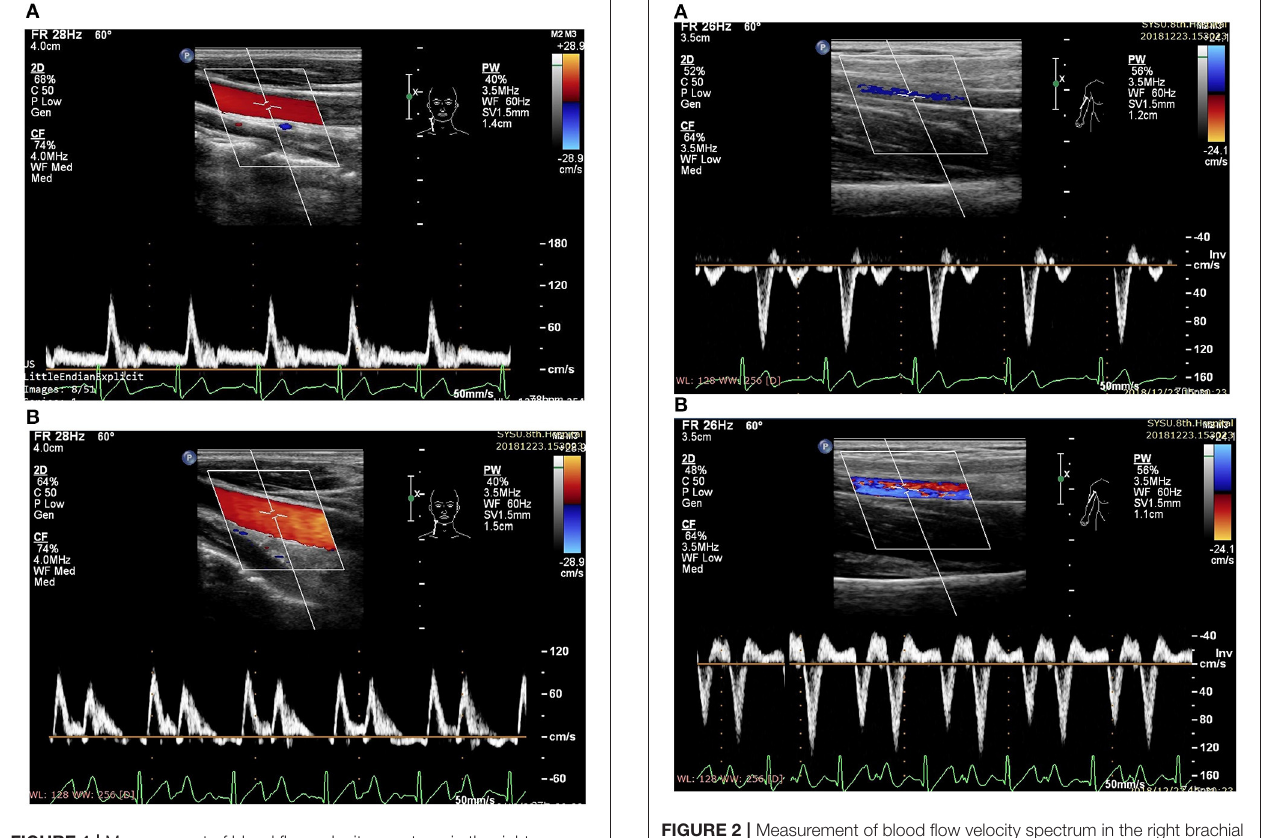
FIGURE 1 | Measurement of blood flow velocity spectrum in the right common carotid artery (CCA) [ A before enhanced external counterpulsation (EECP) and B during EECP].